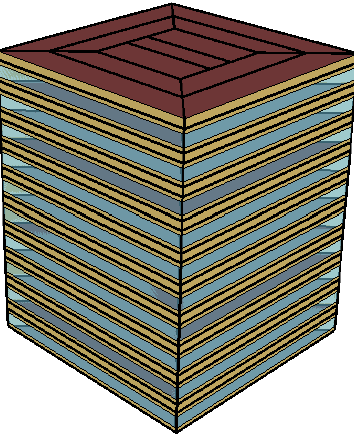
Figure 1. 3-D view of the considered building.